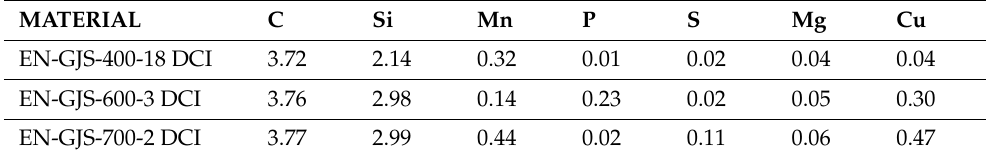
Table 1. Chemical compositions of the three DCIs examined [6,41].